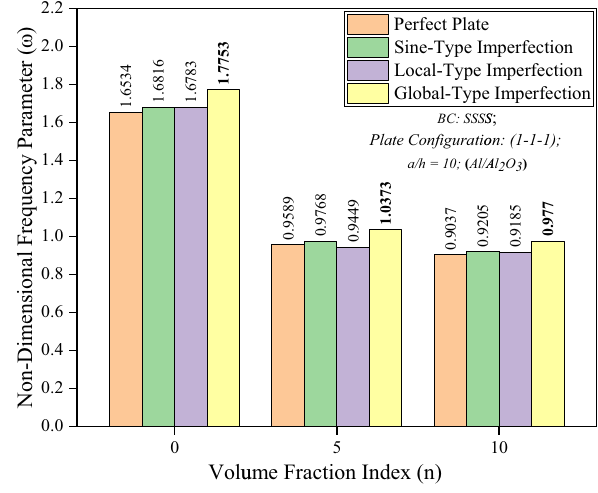
Figure 9: In fl uence of imperfection models on the NDFP of SFGM square plate without cutout under the SSSS boundary condition with ( 1 - 1 - 1 ) plate con fi